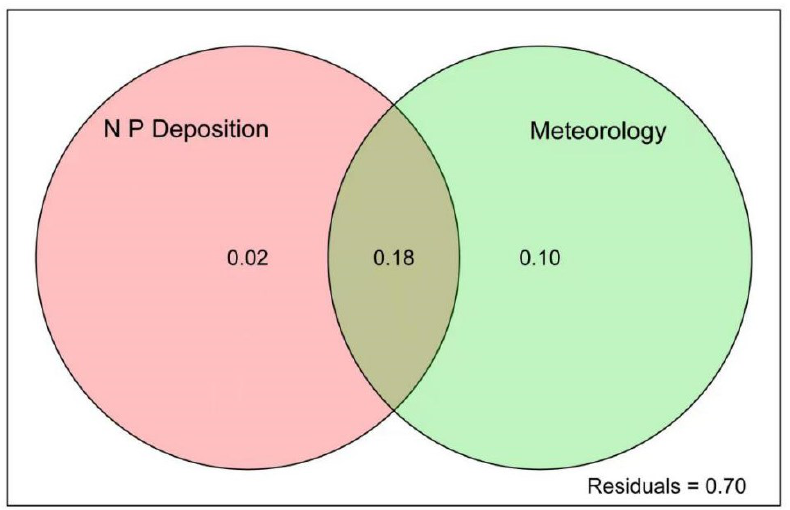
Figure 6. Variance decomposition of atmospheric N and P deposition and atmospheric environmental factors on water quality.